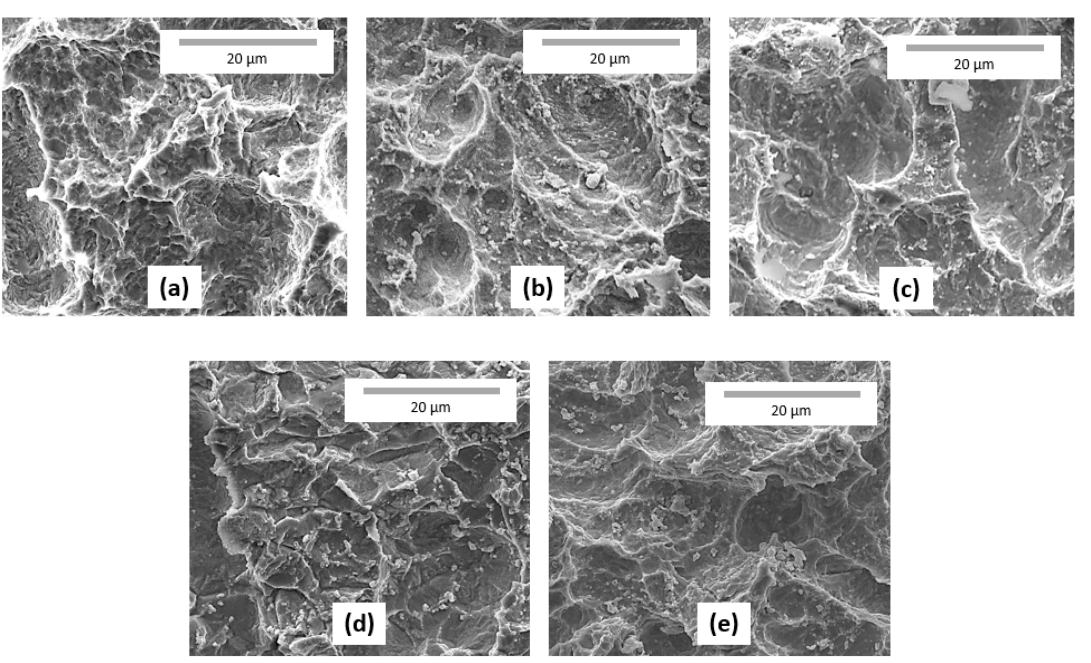
Figure 2. SEM images (at 6000× magnification) of ( a ) the bare sandblasted Ni expanded mesh; ( b ) IrO 2 -E1; ( c ) IrO 2 -F1; ( d ) IrO 2 -G1; and ( e ) IrO 2 -H1.